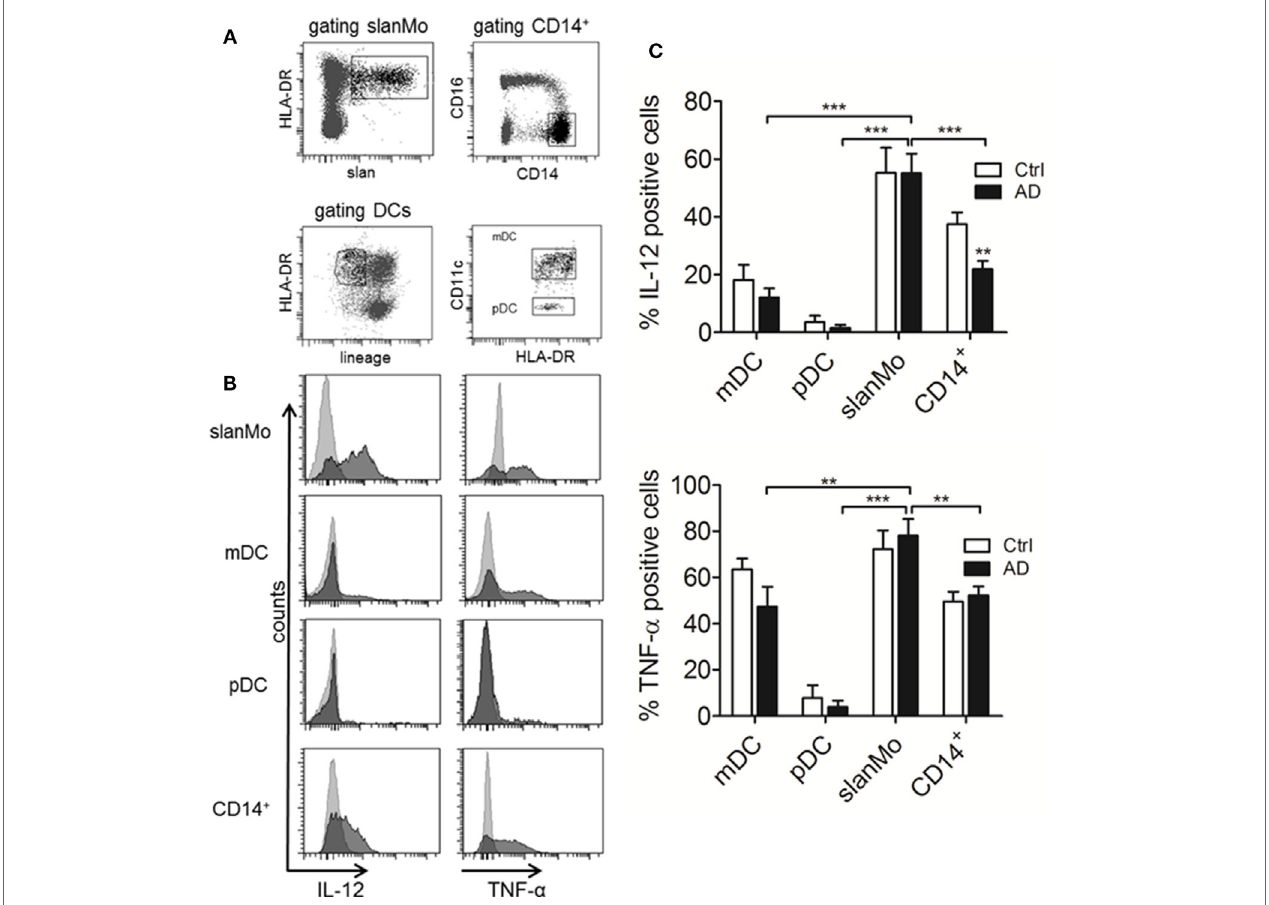
FigUre 4 | IL-12 and TNF- α production in different subtypes of dendritic cells (DCs) and monocyte subsets from healthy donors and atopic dermatitis patients. (a) Gating strategy for the different subsets analyzed in (B,c) is demonstrated. (B) Representative histograms for IL-12 and TNF- α production are shown. Results of multiple donors (Ctrl n = 11, AD n = 15) are depicted in (c) . Data are shown as mean + SEM. Statistical significance between Ctrl and AD within the different DC subsets was calculated using an unpaired t -test and a one-way ANOVA followed by Dunnett’s posttest was used to analyze differences in cytokine production between 6-sulfo LacNAc-expressing monocytes (slanMo) and the other subsets in